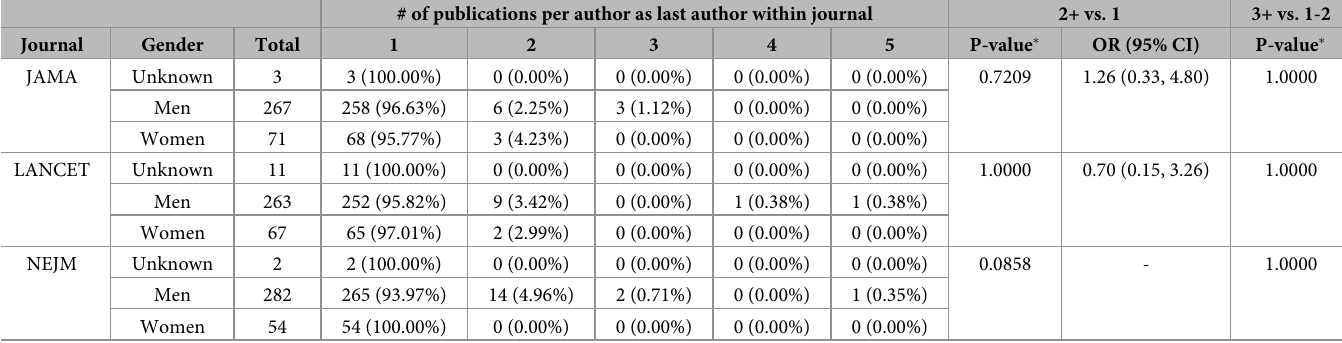
Table 9. Last authors’ multiple top medical research journals’ publications by journal by gender.